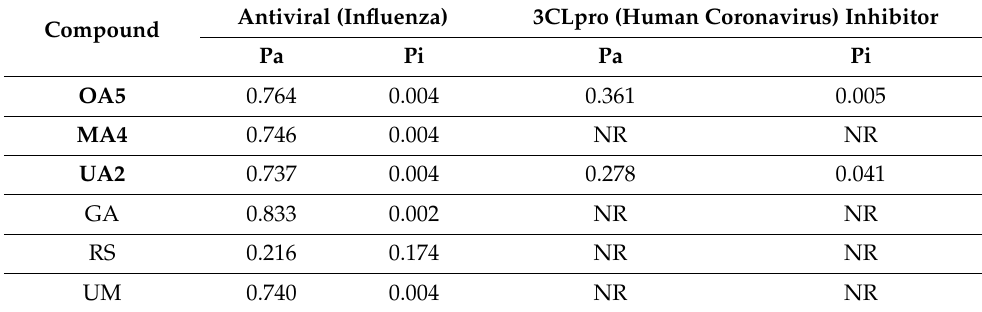
Table 4. Biological properties of the top selected derivatives and the reference molecule. Values predicted with PASS online